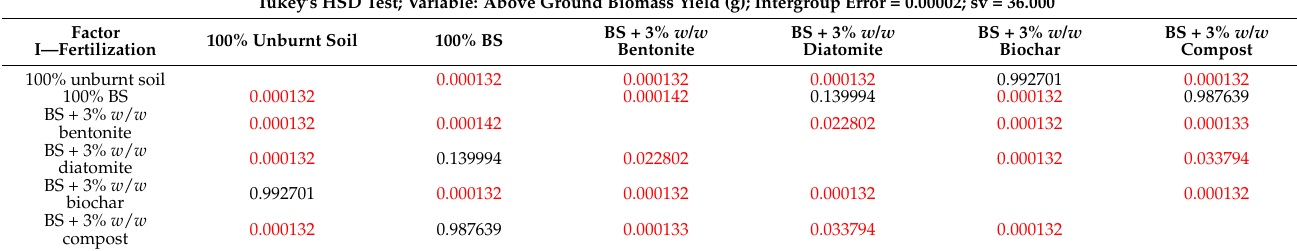
Table A1. Above ground biomass yield—effect of fertilization; significant differences are shown in red.